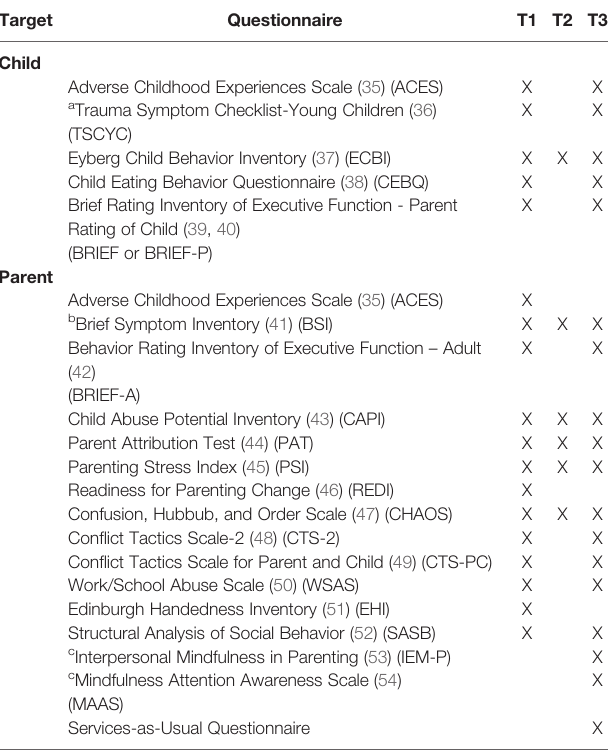
TABLE 1 | Survey measures across T1 pre-treatment, T2 mid-treatment, and T3 post-treatment.